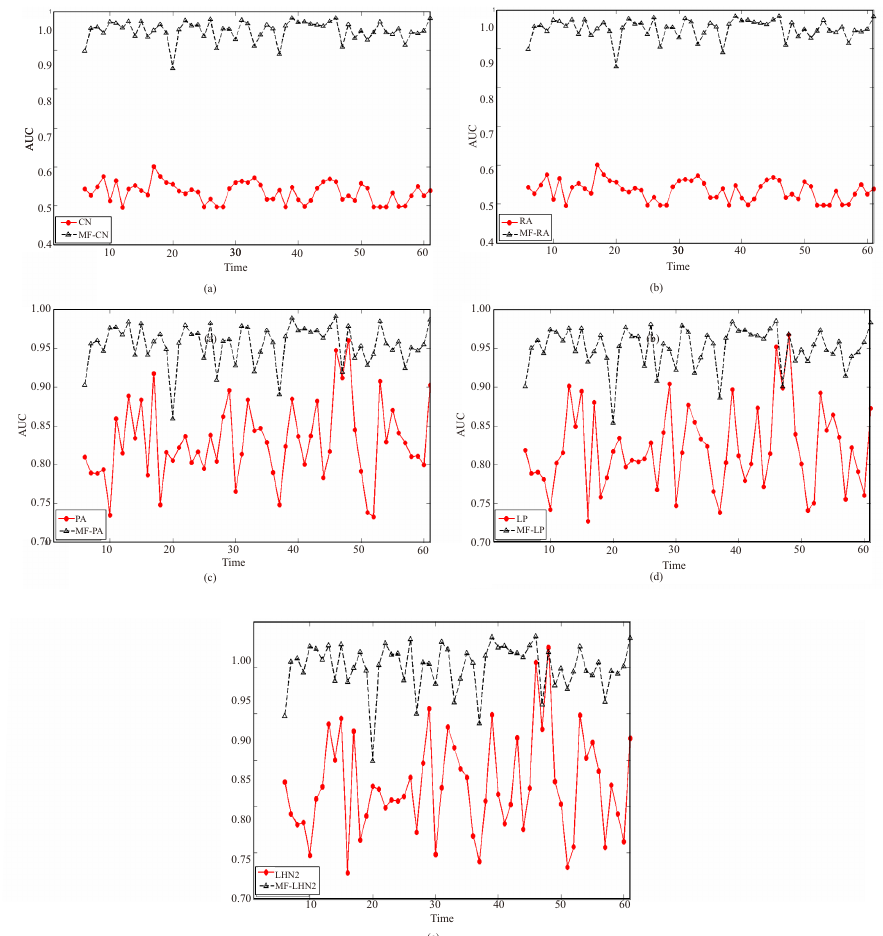
Fig. 6 Performance of different methods on